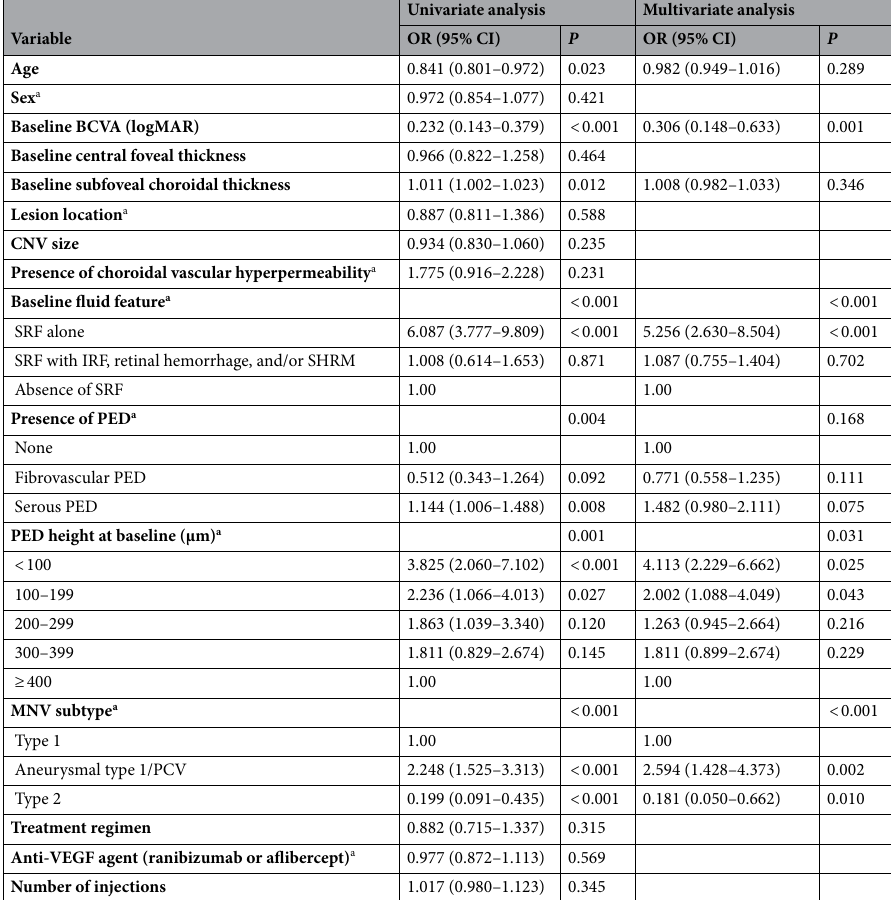
Table 3. Association between baseline ocular characteristics and occurrence of SRF alone during the 2-year anti-VEGF treatment: logistic regression analysis. AMD, age-related macular degeneration; BCVA, best- corrected visual acuity; CI, confidence interval; CNV, choroidal neovascularization; logMAR, logarithm of the minimum angle of resolution; MNV, macular neovascularization; OR, odds ratio; PCV, polypoidal choroidal vasculopathy; PED, pigment epithelial detachment; SRF, subretinal fluid; VEGF, vascular endothelial growth factor. The R-squared of the model was 0.563. a Categorical